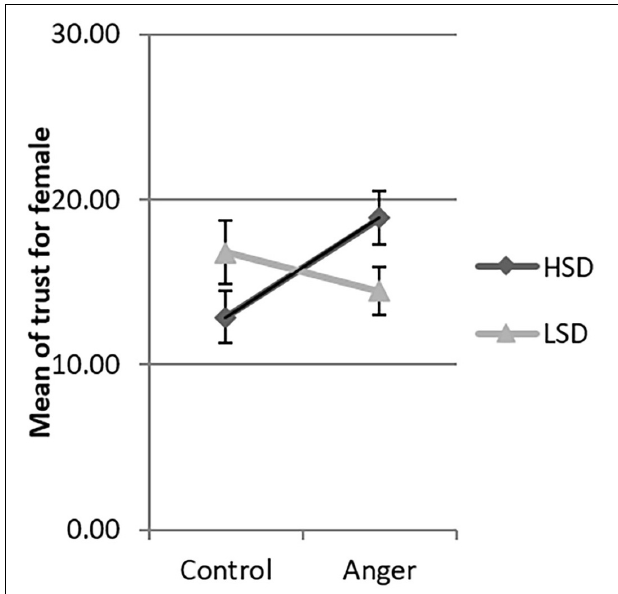
FIGURE 2 | Mean of trust of female the four experimental conditions in Study 1. LSD, low social distance; HSD, high social distance. Error bar is the standard error.